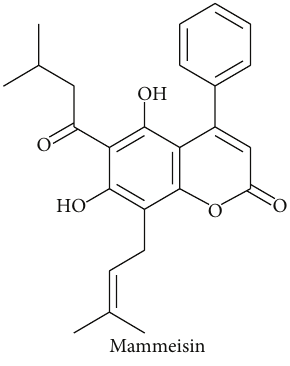
Figure 1: Chemical structure of